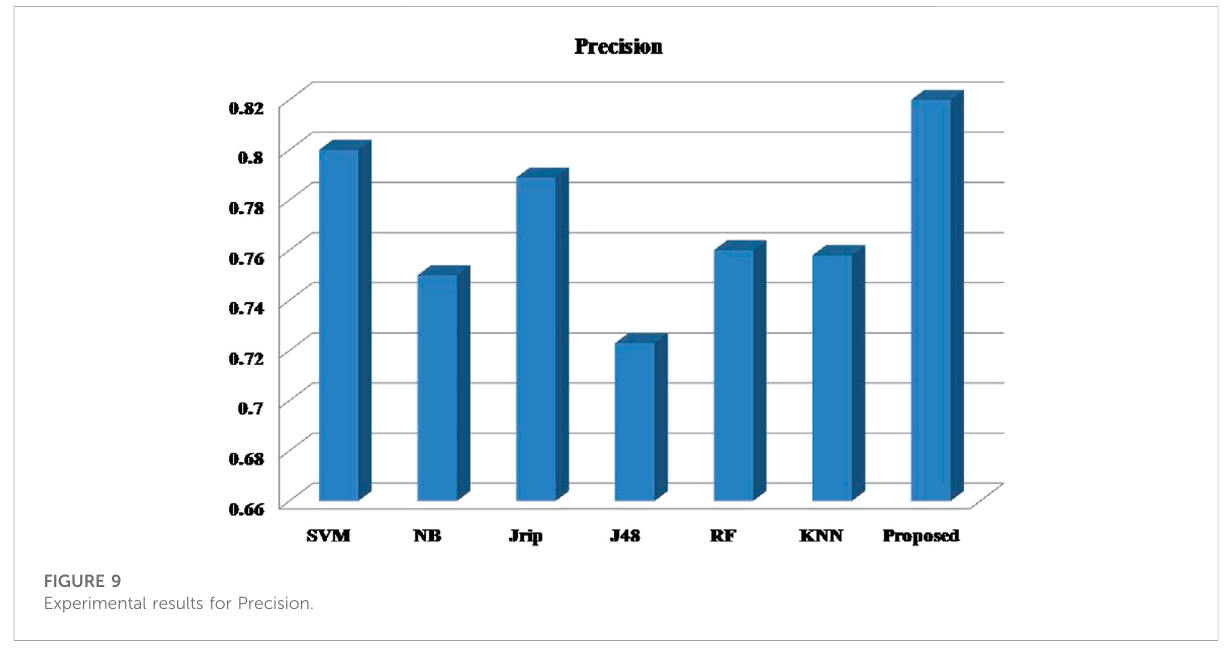
FIGURE 9 Experimental results for Precision.